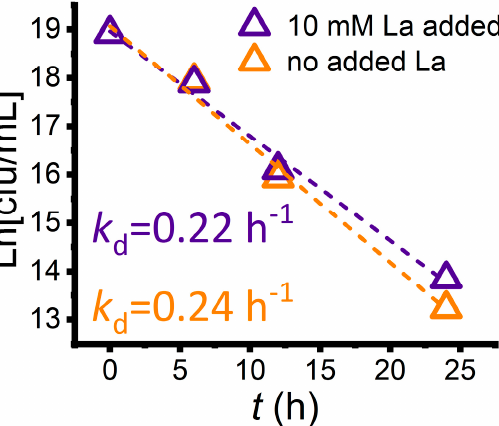
Figure 6. Change of natural logarithmic CFU over time under conditions with/without lactic acid as an electron donor.